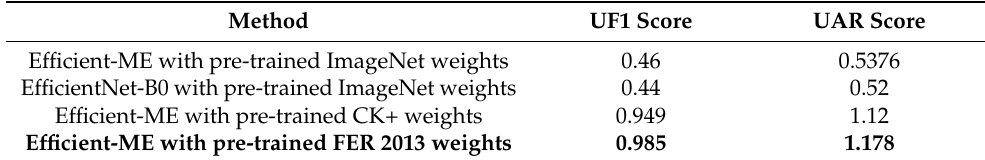
Table 5. Transfer learning evaluation using ImageNet, FER 2013 and CK+ source